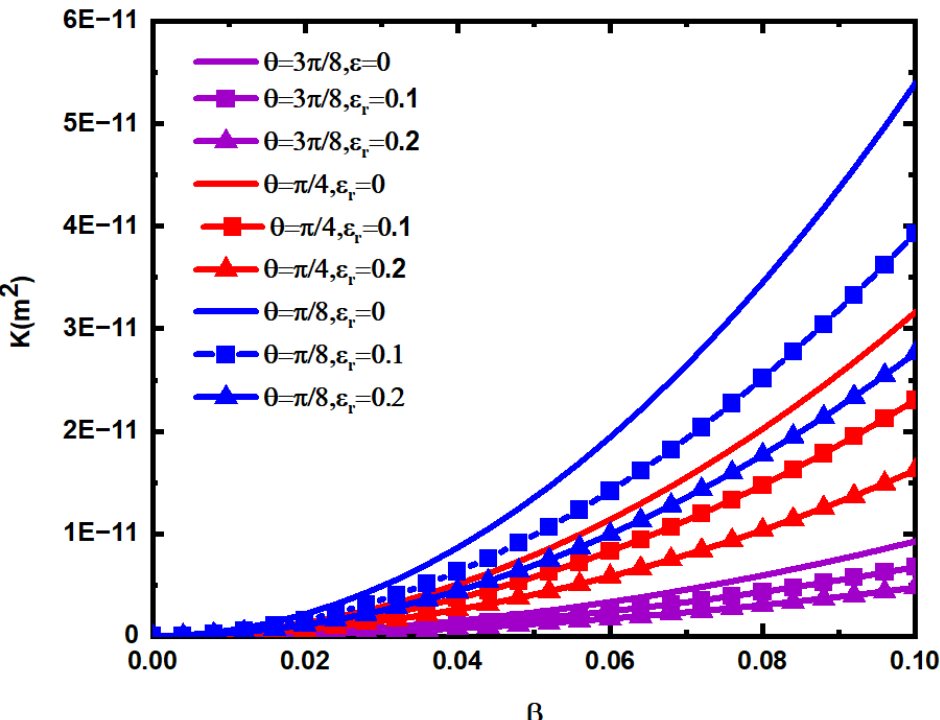
K Figure 13. Relationship between the permeability K of the fractured dual porous media and the Figure 13. Relationship between the permeability of the fractured dual porous media and the ε β ratio β of fracture opening to trace length, the relative roughness ε r of the fracture network, and the of fracture opening to trace length, the relative roughness r of the fracture network, and ratio average inclination angle θ . θ the average inclination angle .